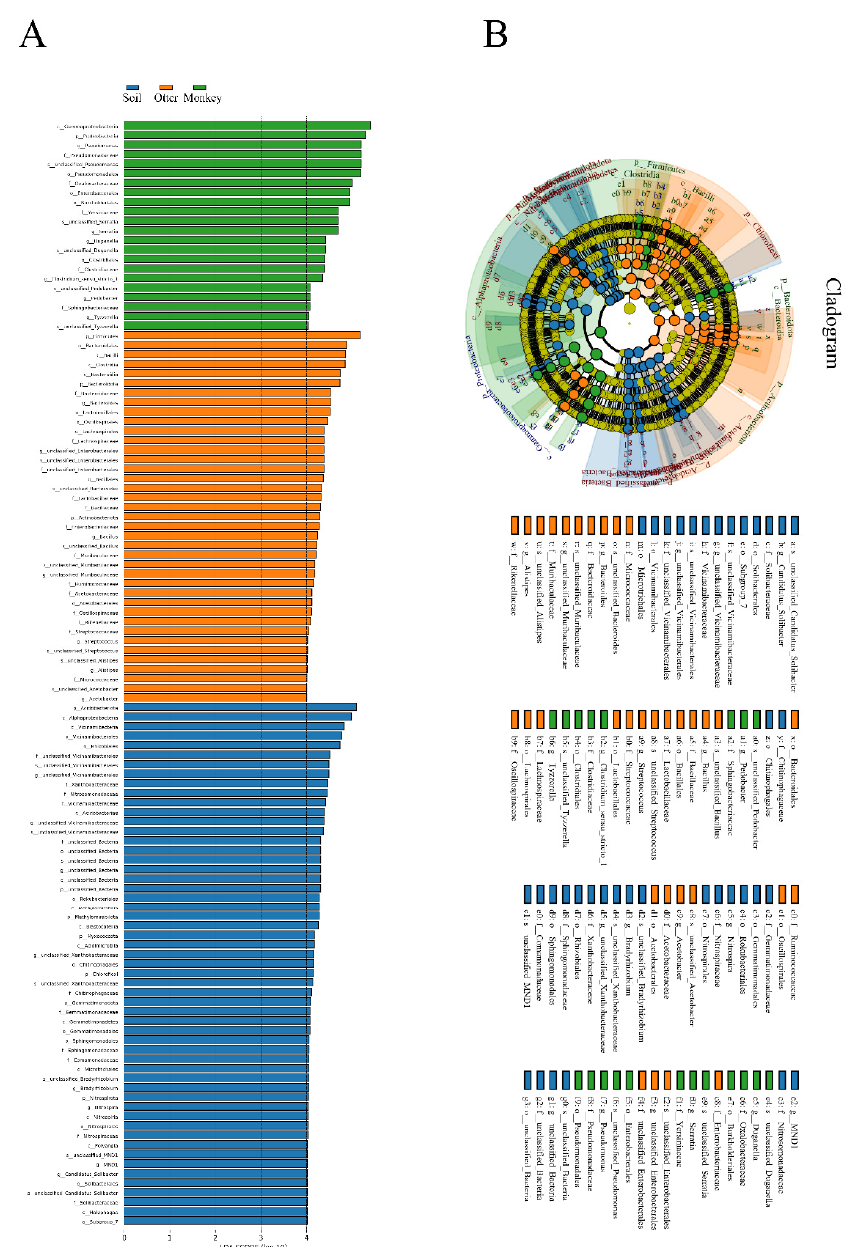
Figure 6. Histogram of the linear discriminant analysis (LDA) effect size ( A ) and cladogram ( B ) for genera differentially abundant between the habitat soil microbiome and gut microbes of Eurasian otters and golden snub-nosed monkeys. Only the genera with a linear discriminant analysis signif- icance threshold > 2 are shown.